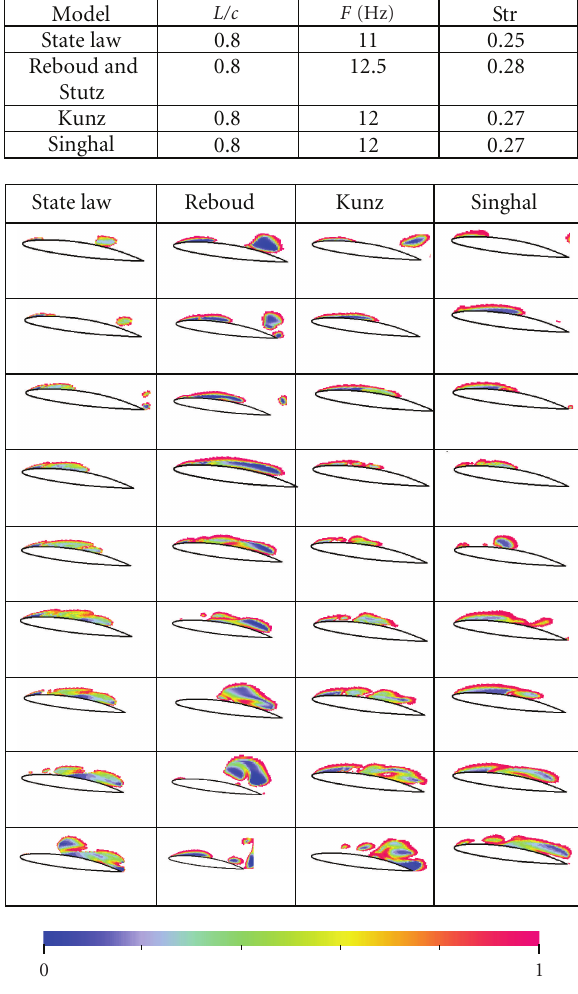
Figure 18: Void fraction distributions ( L/c = 0 . 8, V ref = 6m/s).